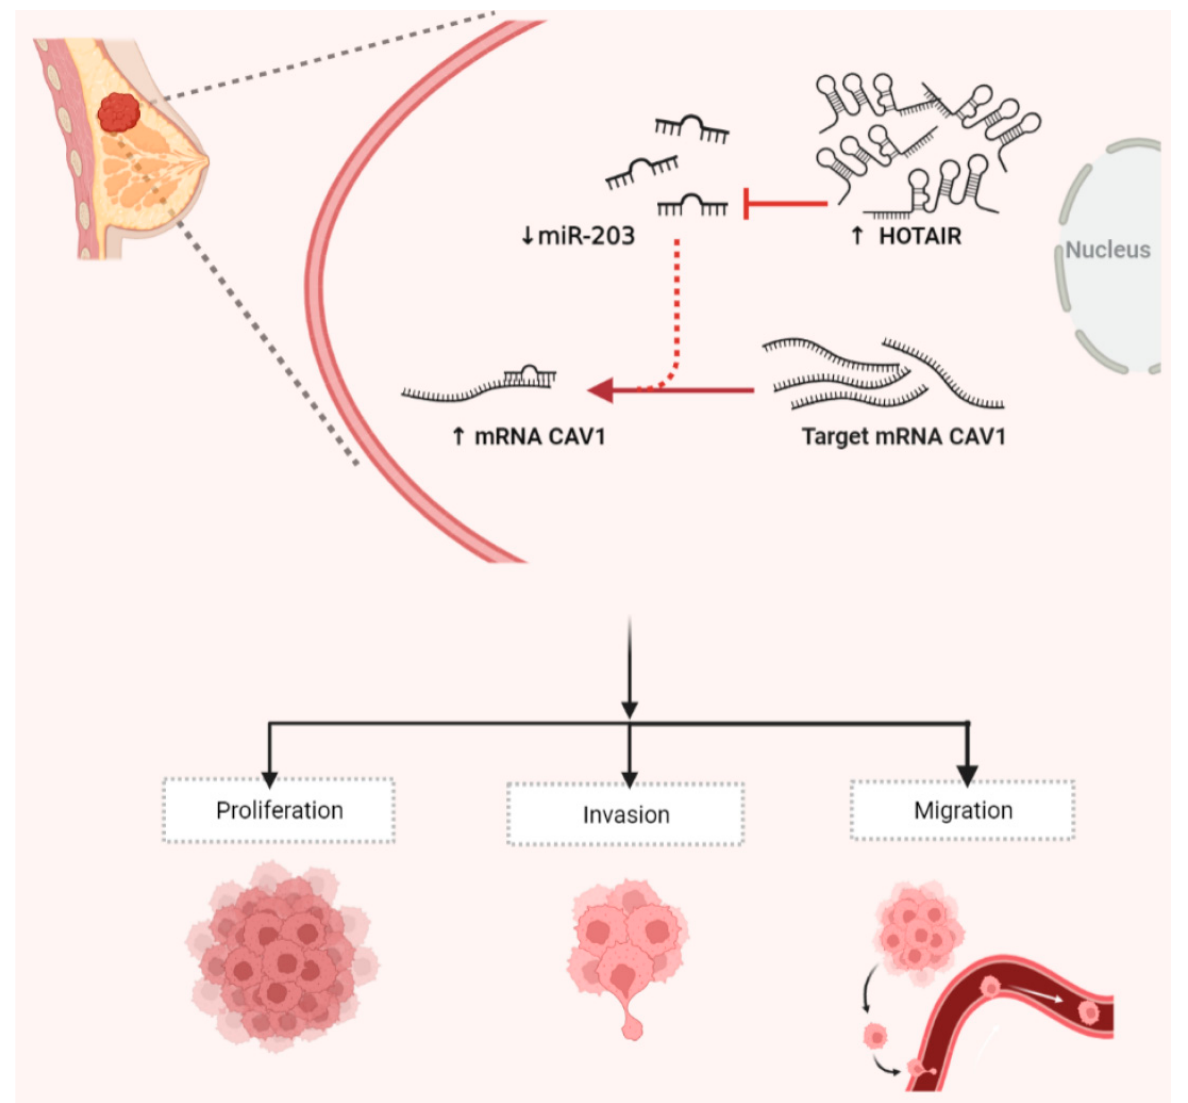
Figure 7. HOTAIR / miR-203 / CAV1 crosstalk influences proliferation, migration, and invasion in breast cancer cells. In breast cancer cells, the highly expressed HOTAIR might act as a ceRNA to bind with miR-203 , which increases the expression of CAV1 , thereby promoting the proliferation, invasion, and migration of breast cancer cells. The figure was constructed with BioRender (https://biorender.com/, accessed on 11 May 2022).